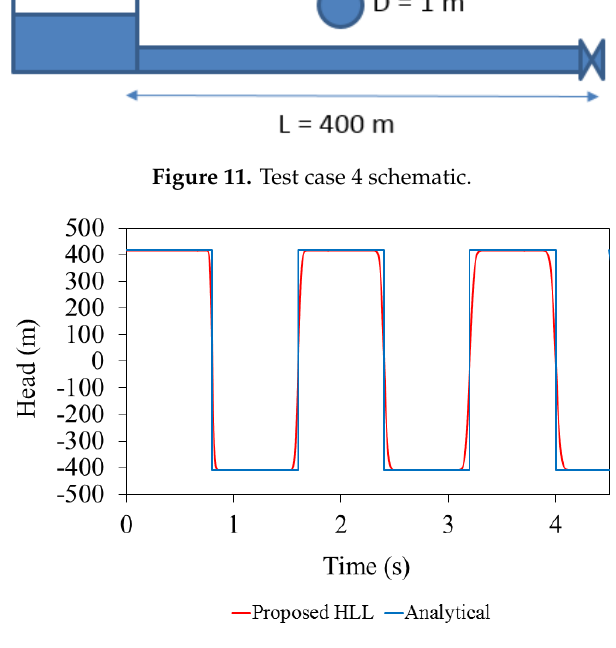
Figure 12. Waterhammer pressure oscillations.